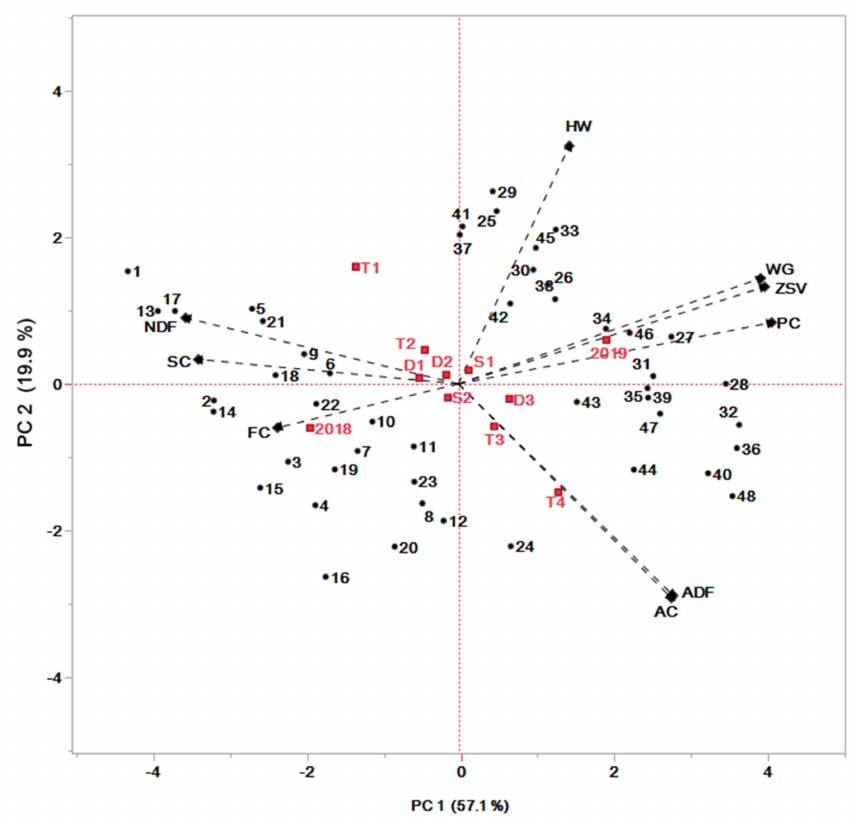
Figure 2. Categorization of the examined features by the biplot analysis method and the relationships of the traits examined.